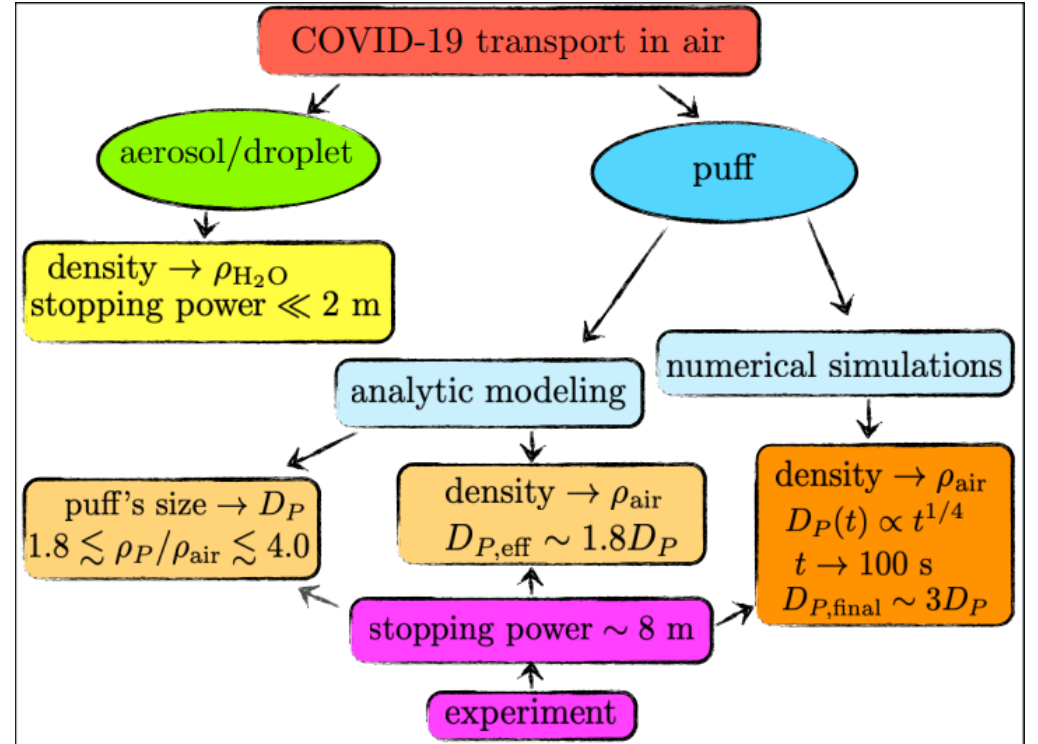
Figure 2. A flow chart showing the research methodology. The study of COVID-19 transport in air has been carried out using a modeling of the turbulent cloud. For a coherent length of 𝑫 𝑷 the average density becomes 𝟏.𝟖 < 𝝆 𝑷 /𝝆 𝒂𝒊𝒓 < 𝟒. 𝟎 . For 𝝆 𝑷 ∼ 𝝆 𝒂𝒊𝒓 the effective size of the puff is 𝑫 𝑷, 𝒆𝒇𝒇 ∼ 𝟏.𝟖 𝑫 𝑷 . The latter is consistent with simulation studies which show that the coherent length evolves in time proportional to 𝒕 𝟏/𝟒 , and so after 100 s the final size of the coherent turbulent cloud is 𝑫 𝑷, 𝒇𝒊𝒏𝒂𝒍 ∼ 𝟑 𝑫 𝑷 . Viral transmission pathways have profound implications for public safety. Our study forewarns a